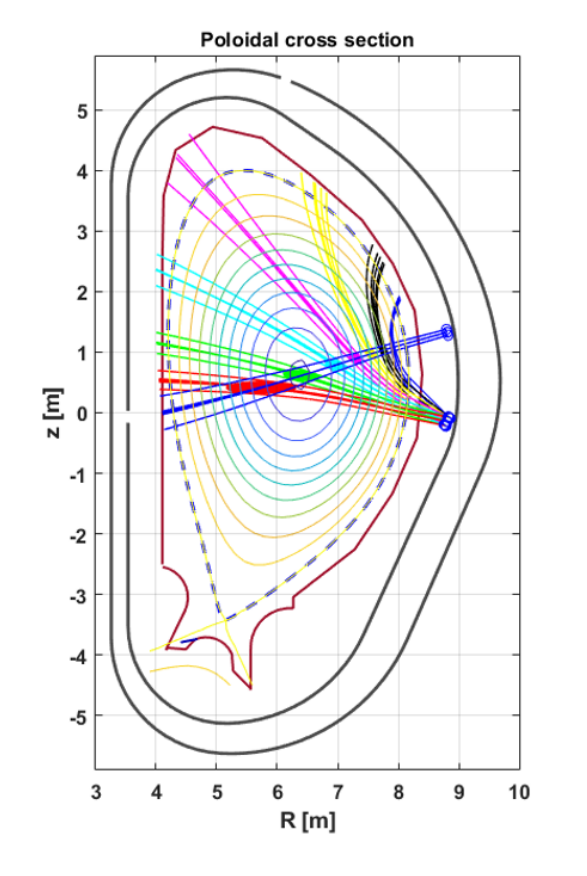
Fig. 7. Poloidal view of the ray tracing results for the ITER CTS probe and the seven receiver beams. The equilibrium is for Scenario 1 (reference scenario) and has been provided by F4E. The electron density and temperature profiles for the scenario are presented in Figure 8.